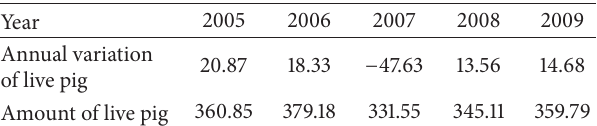
Table 2: The historical record of live pig from 2005 to 2009 (ten thousand